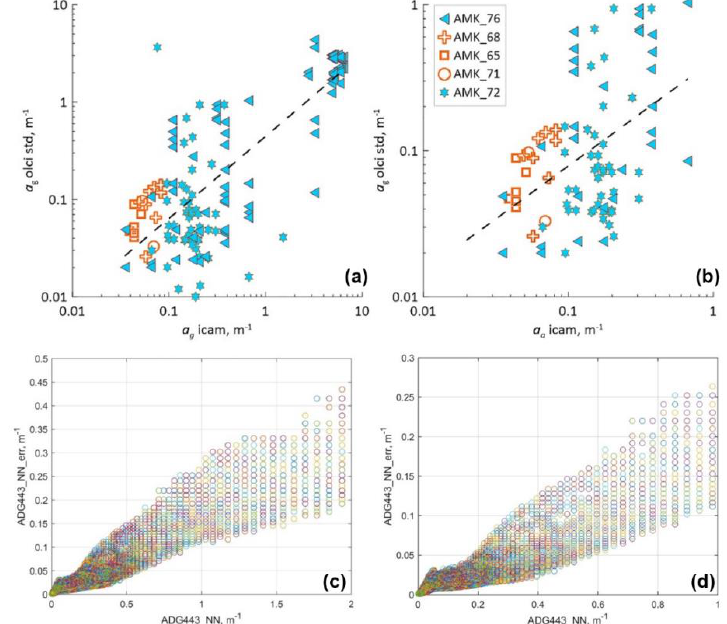
Figure 3. Top: scatter plots of the in situ measured and satellite derived a g (443) values: ( a )—complete dataset; ( b )—river estuary data excluded. The Barents Sea points are shown in orange, the Kara and Laptev seas are shown in turquoise. Various cruises are represented by symbols. The dotted line is the correlation across all data. Bottom: the standard product errors ADG_443_NN_err in comparison with the ADG_443_NN values for OLCI Level 2 file S3A_OL_2_WFR_20170814T091713; ( c ) complete dataset; ( d ) the same in the enlarged scale. The Barents Sea, 14 August 2017.